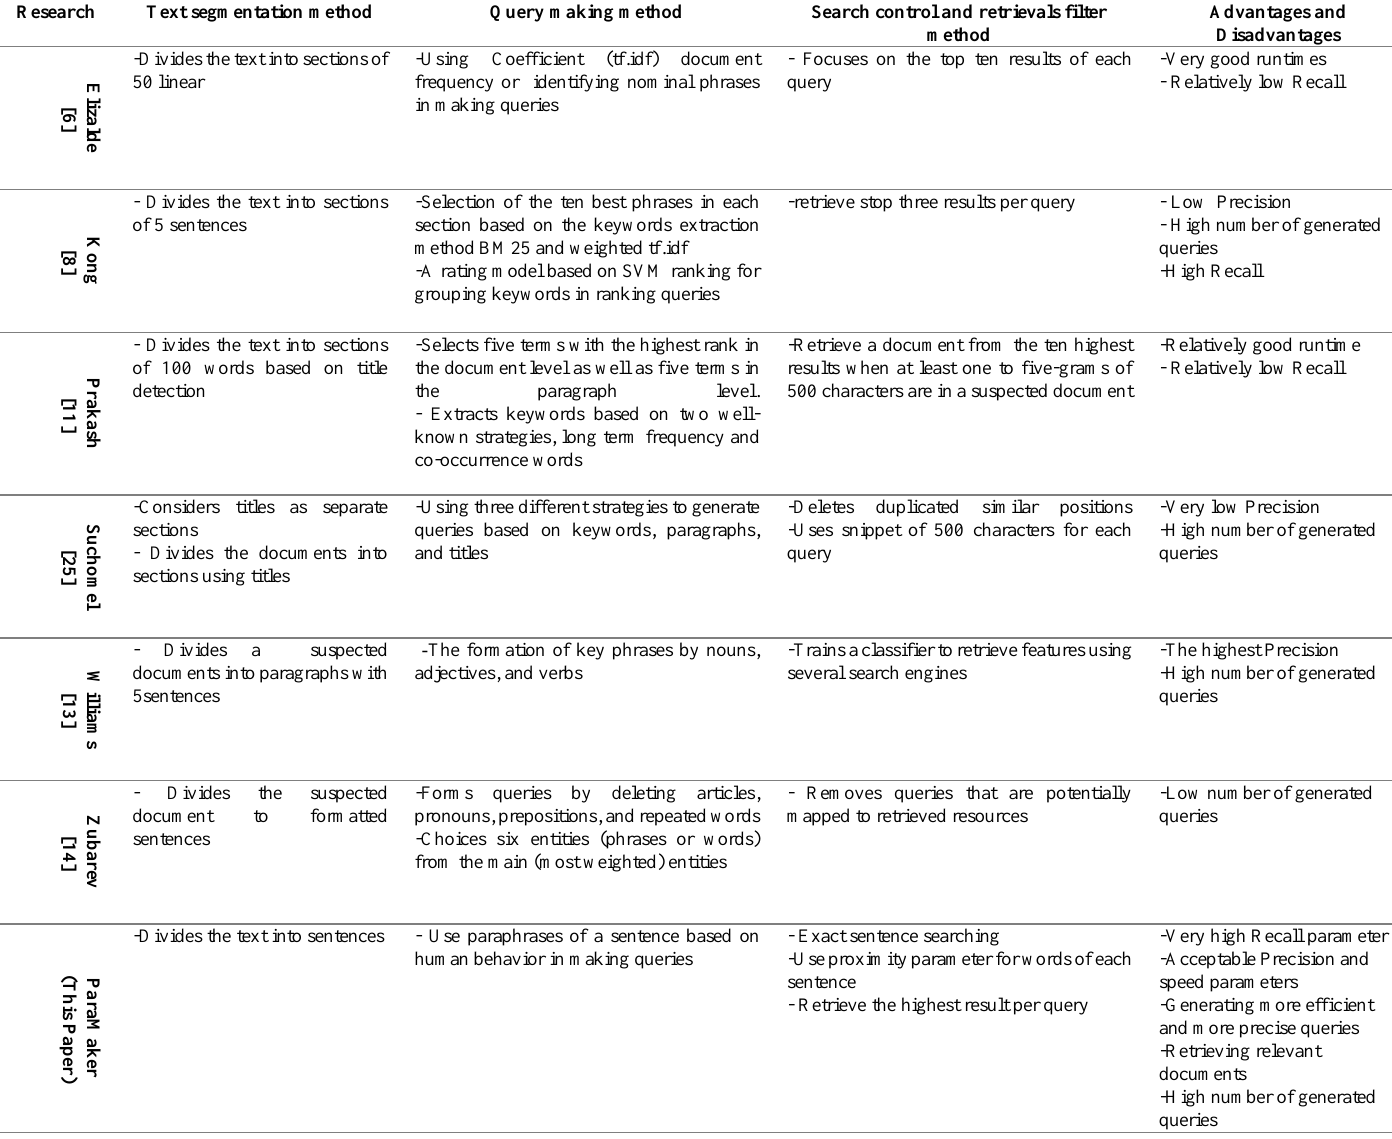
Table 2. Comparison of resource retrieval